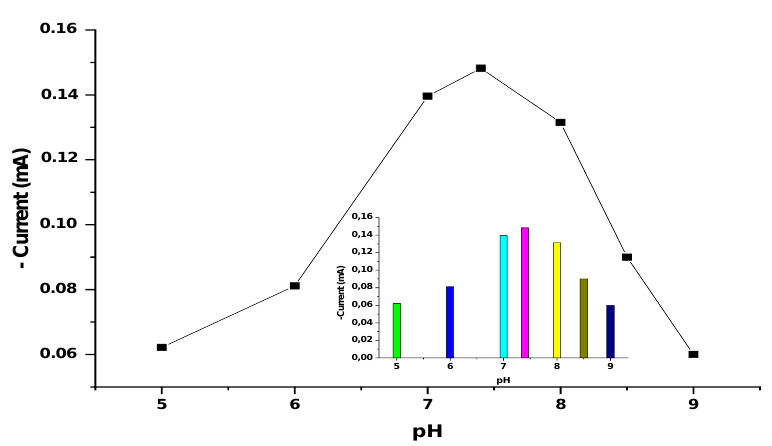
Figure 9. The effect of pH on the biosensor response. [Working conditions; phosphate buffer, 50 mM and T = 35 °C. 5 mg/mL amlodipine solution].